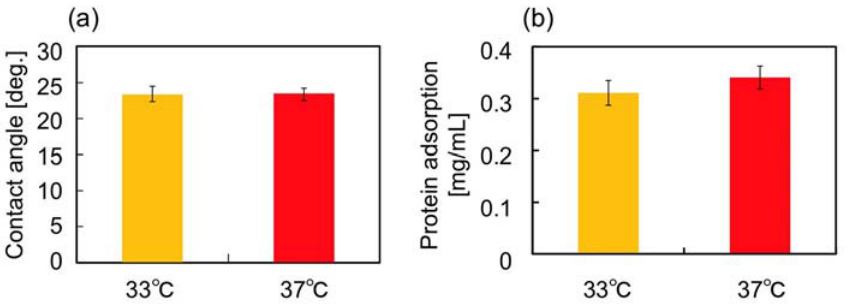
Figure 2. ( a ) Contact angles and ( b ) amount of serum protein adsorption on the PNIPAAm gel at 33 and 37 °C. Data are expressed as the mean of three measurements (± standard